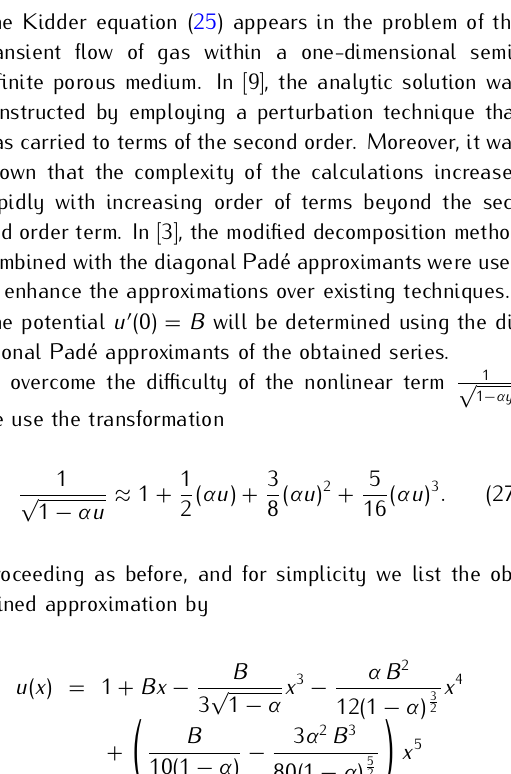
[3 / 3] for 0 ≤ x ≤ 1 ,α = 0 .